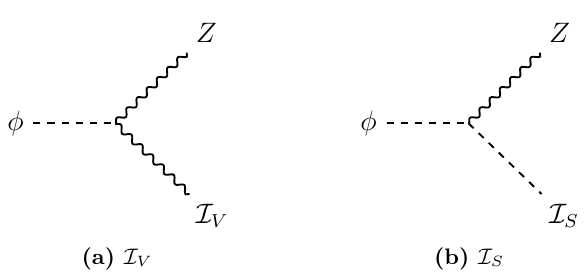
Figure 3. Mono- Z + E miss